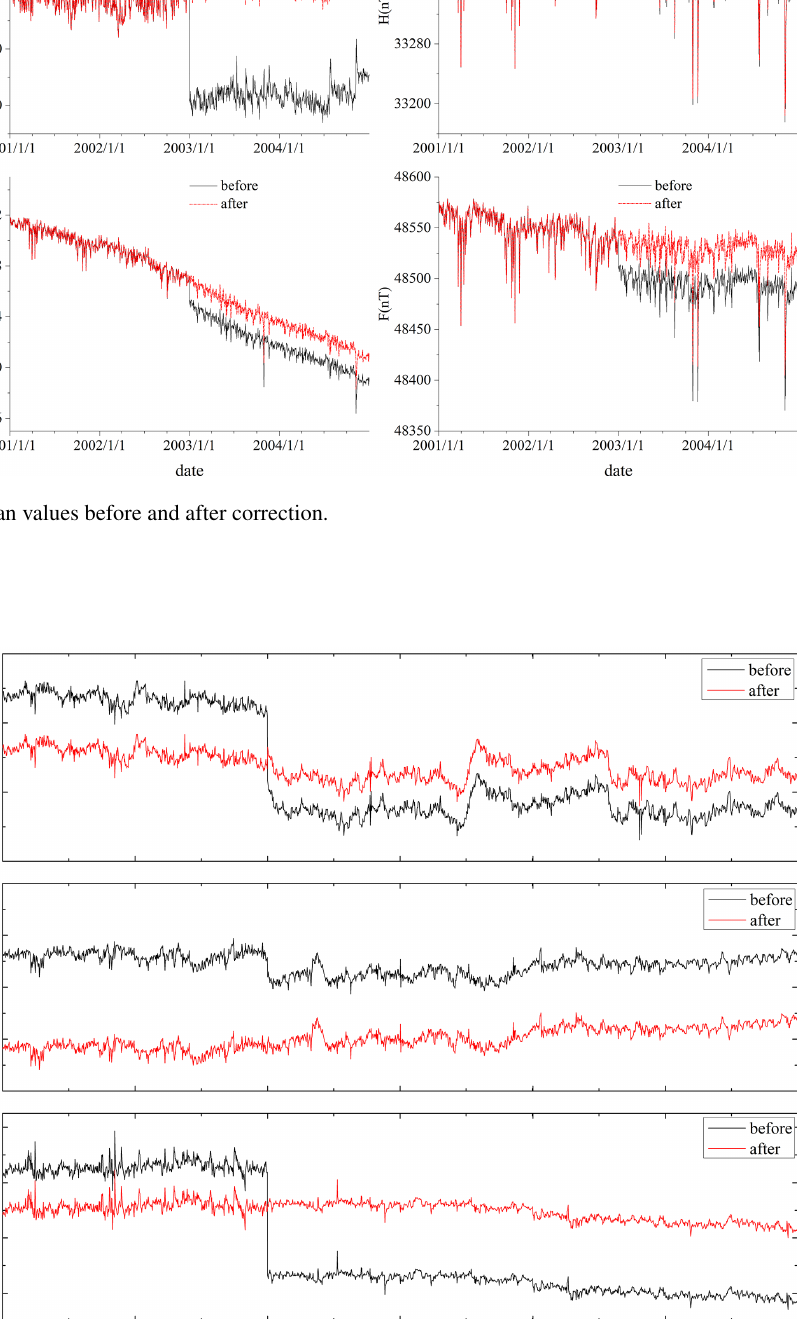
Earth Syst. Sci. Data, 14, 5195–5212, 2022